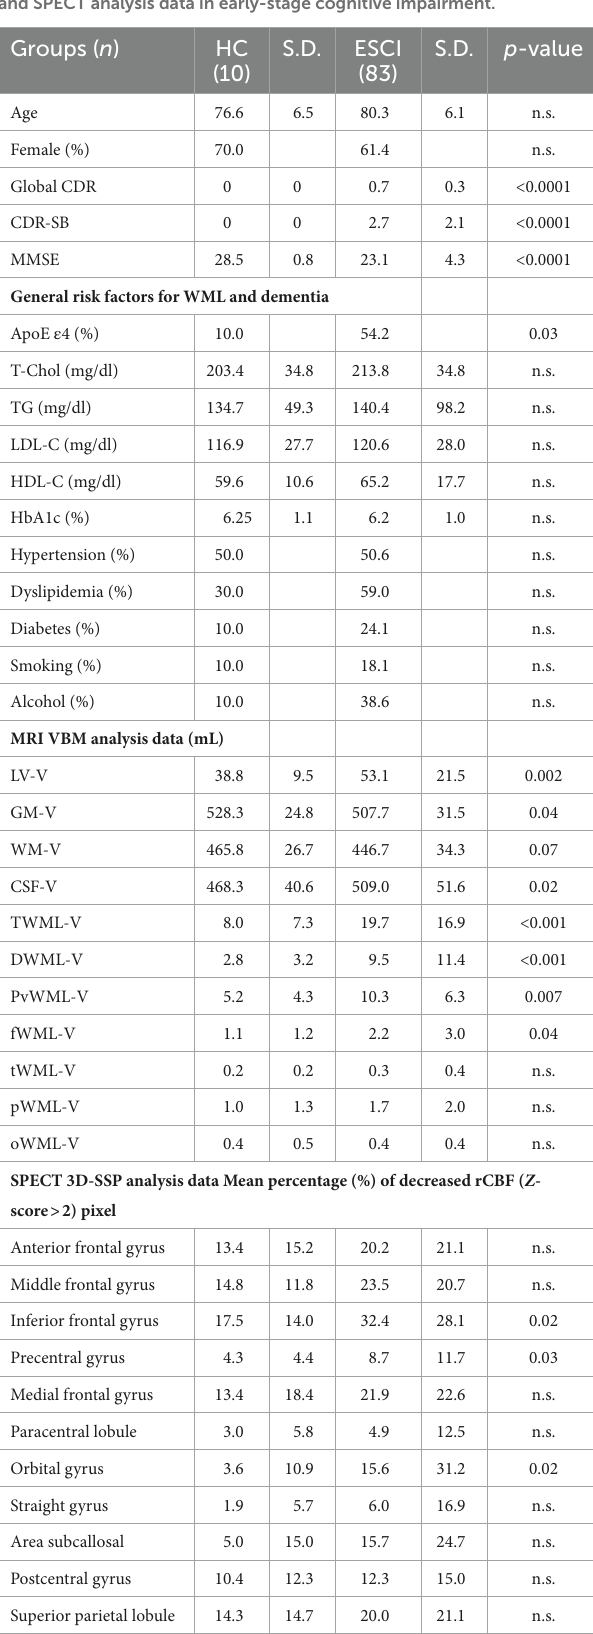
The results of the correlation analysis between MRI VBM data and cognitive measures (MMSE, LV-V, CSF-V, TWML-V, and PvWML-V) revealed a statistically significant negative association with MMSE scores (Figure 3A). The cortical regions in which the percentage of pixels with decreased rCBF (Z-score > 2), measured by SPECT 3D-SSP analysis, showed a significant correlation with MMSE were the inferior frontal gyrus; straight gyrus; subcallosal area; superior and inferior parietal lobules; angular gyrus; supramarginal gyrus; superior, middle, and inferior temporal gyri; fusiform gyrus;